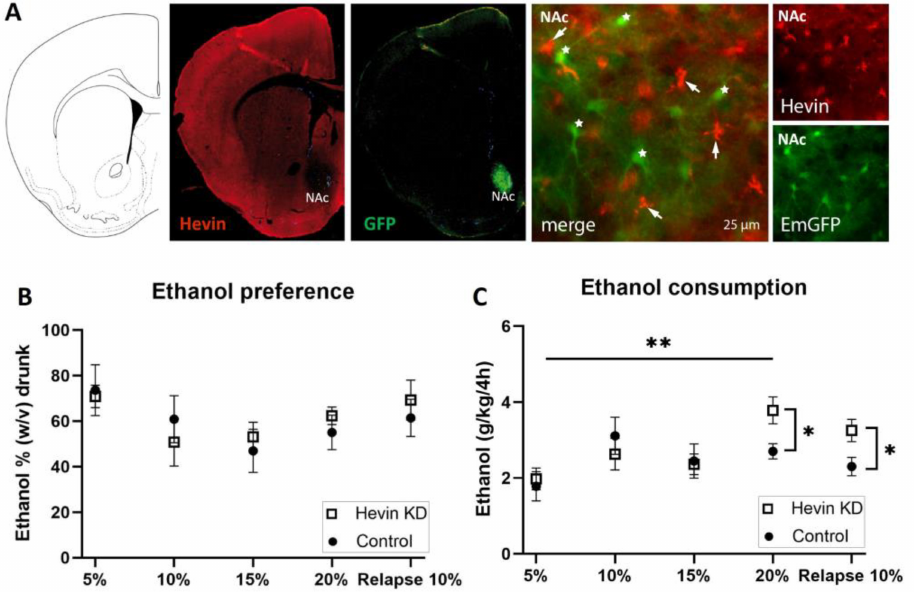
Figure 5. Effect of hevin protein downregulation in nucleus accumbens (NAc) astrocytes on ethanol consumption in mice. ( A ) Immunohistochemical validation of hevin downregulation in NAc astrocytes after injection of miRNA-containing viruses. Hevin immunofluorescence, in red, is absent in astrocytes infected with hevin miRNA and co-expressing EmGFP (star). Non-transfected astrocytes express hevin (arrow). ( B ) Ethanol preference quantification every third day of each ethanol concentration. ( C ) Ethanol consumption quantification every third day of each ethanol concentration. The ordinate represents the average of the percentage of ethanol taken by hevin KD and control groups ( B ) or the grams of ethanol per kg of mouse weight taken in 4 h ( C ). The abscissa shows the ethanol concentration tested. n = 8/group. Mann-Whitney test was used for the comparison of the preference and consumption between the hevin KD mice and controls (* p < 0.05, ** p < 0.01); and Friedman followed by Dunn’s post-hoc test was used for the comparison of the preference and consumption between ethanol concentrations. Values represent mean ±